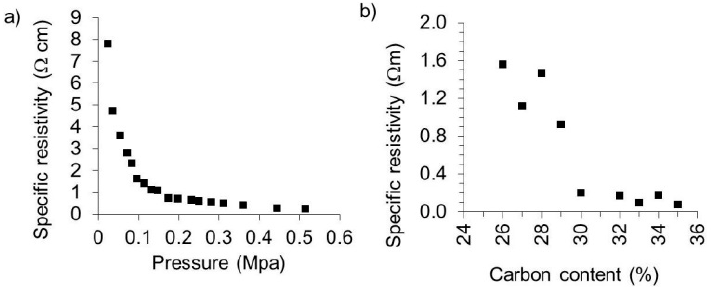
Figure 8. ( a ) Pressure dependence of specific resistivity for carbon particles made of organosolv lignin particles; ( b ) Effect of carbon microparticle content on specific resistivity of poly (lactic acid).